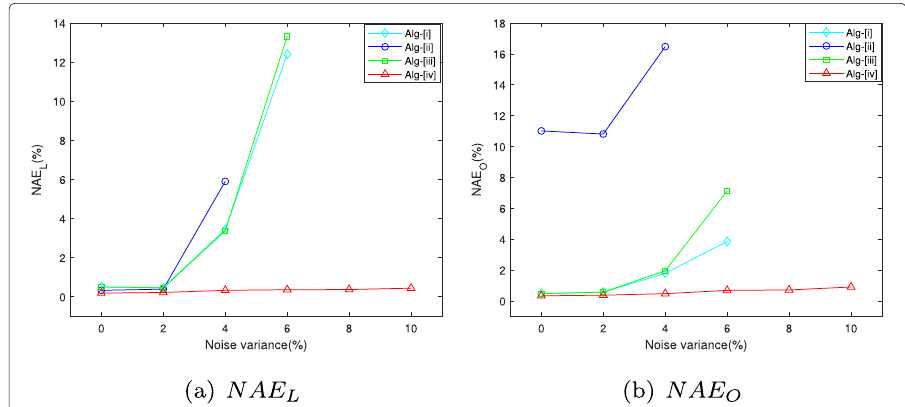
Fig. 6 Performance analysis of the circular pose estimation algorithms in terms of ( a ) NAE L and ( b ) NAE